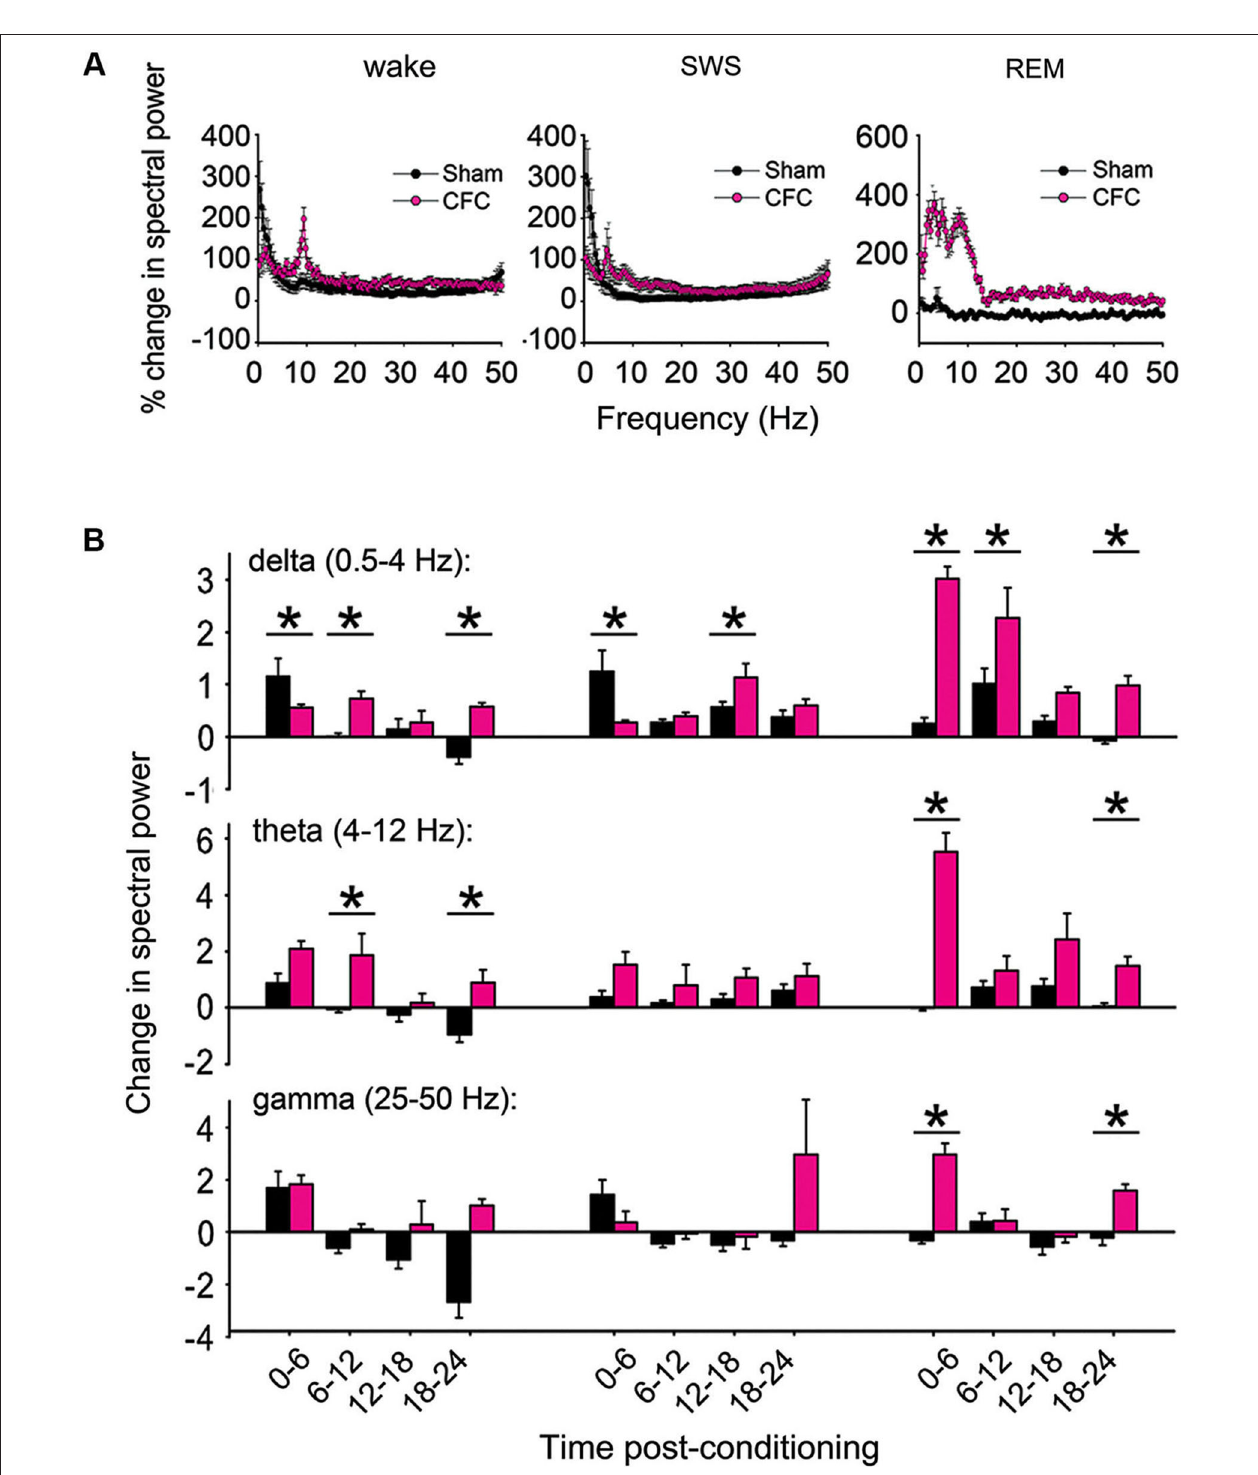
arithmetic sum of these changes (measured at 0.4 Hz intervals) × 10 3 . While the largest post-CFC changes were seen in the theta-frequency range during REM (with relative increases peaking at around 7–4 Hz), significant increases in theta were also present following CFC in wakefulness, as in delta and (to a lesser extent) gamma-frequency bands. * indicates p < 0.05, Holm-Sidak post-hoc test for baseline vs. post-CFC